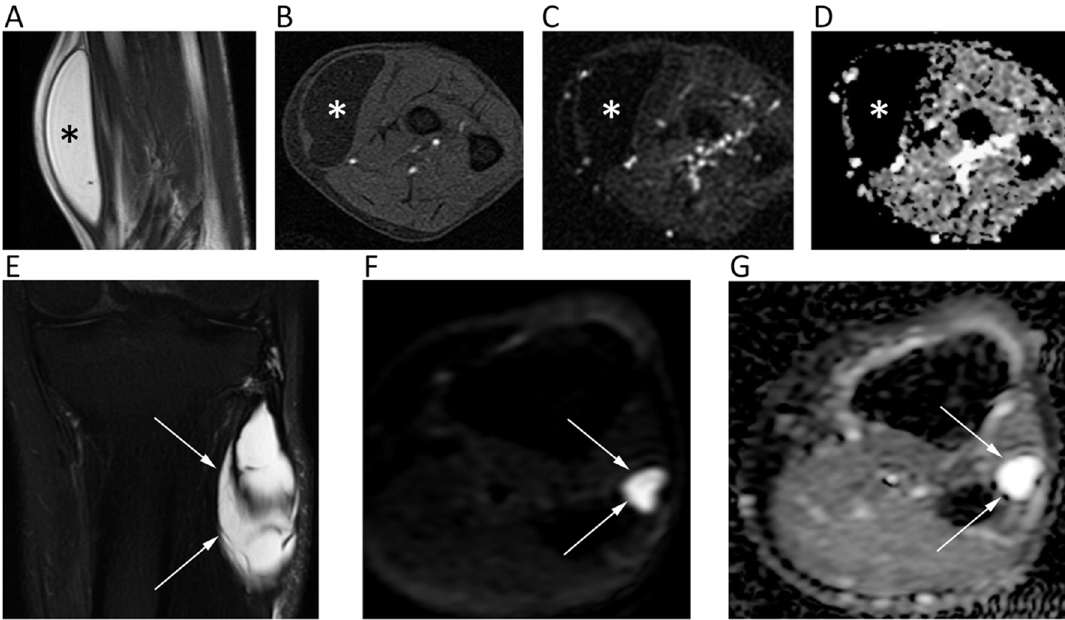
Figure 13. MR images of an intramuscular lipoma of the forearm ( A – D ) and a perineural ganglion cyst of the leg ( E – G ) of two different patients. The lipoma (asterisk) shows a homogeneous high signal on coronal T2w ( A ) and a low signal on axial fat-suppressed T1w (B), b = 800 DWI ( C ); the corresponding ADC map ( D ). Note the absence of diffusion restriction and the intrinsically low ADC values of this benign lipomatous lesion. The ganglion cyst (arrows) displays high signal intensity on coronal fat-suppressed T2w ( E ), axial b = 800 DWI ( F ), and axial ADC map ( G ). High b -value DWI shows high signal due to T2 shine-through effect; the ADC map confirms the absence of diffusion restriction and the cystic nature of the lesion (ADC: 2.603 × 10 − 3 mm 2 /s).